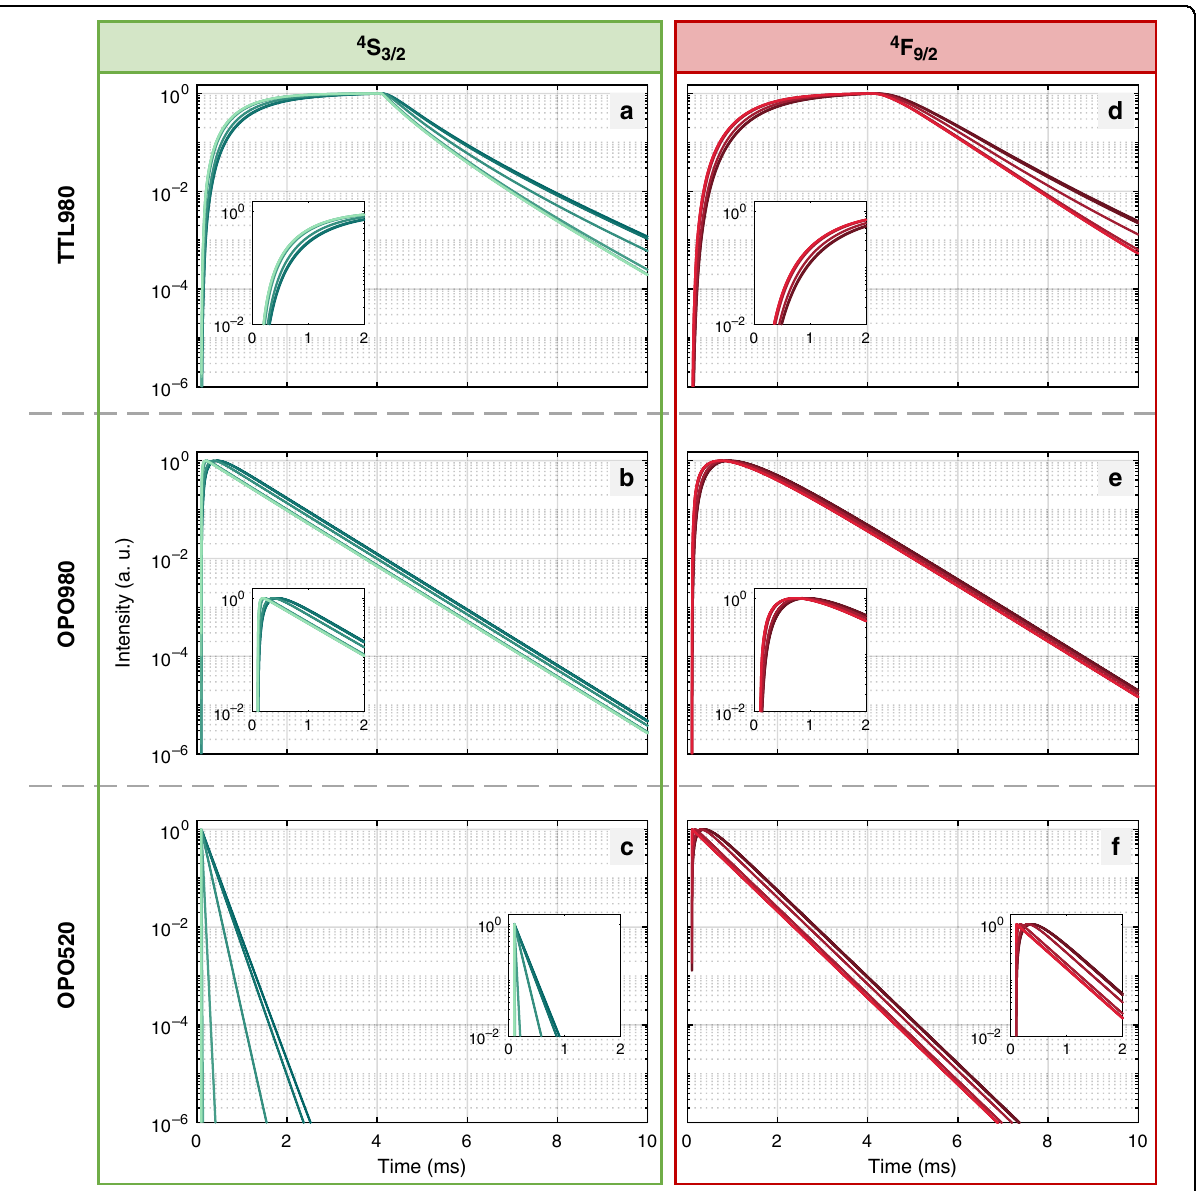
Fig. 5 Luminescence kinetics for Yb-Er donor and RB acceptor UC-LRET system based on a theoretical model of differential rate equations. The acceptor concentration-dependent kinetics of 4 S 3/2 level (left column: a – c ) and 4 F 9/2 (right column d – f ) of Er 3 + derived with DRE modeling for the three excitation schemes: TTL triggered 4 ms 980 nm CW laser diode pulse (top row, a , d ), ca. 10 ns 980 nm OPO laser pulse (middle row, b , e ) and ca. 10 ns 520 nm OPO laser pulse (bottom row, c , f ). The acceptor concentration increases from the darkest (no acceptor present) to the lightest color (highest concentrations; details of the model in